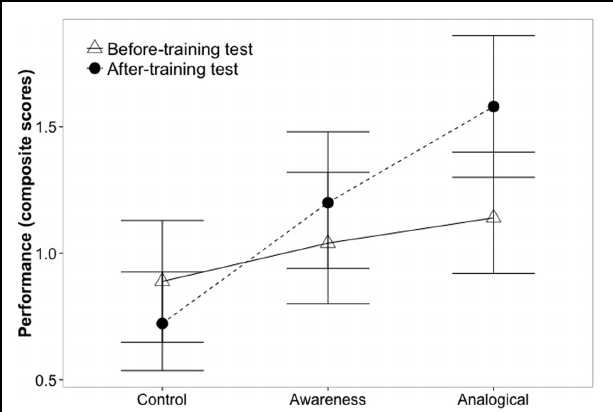
FIGURE 1 | Performance in the different conditions for the statistical biases. Means and 95% bootstrapped confidence intervals for pre- and post-training tests for each condition are